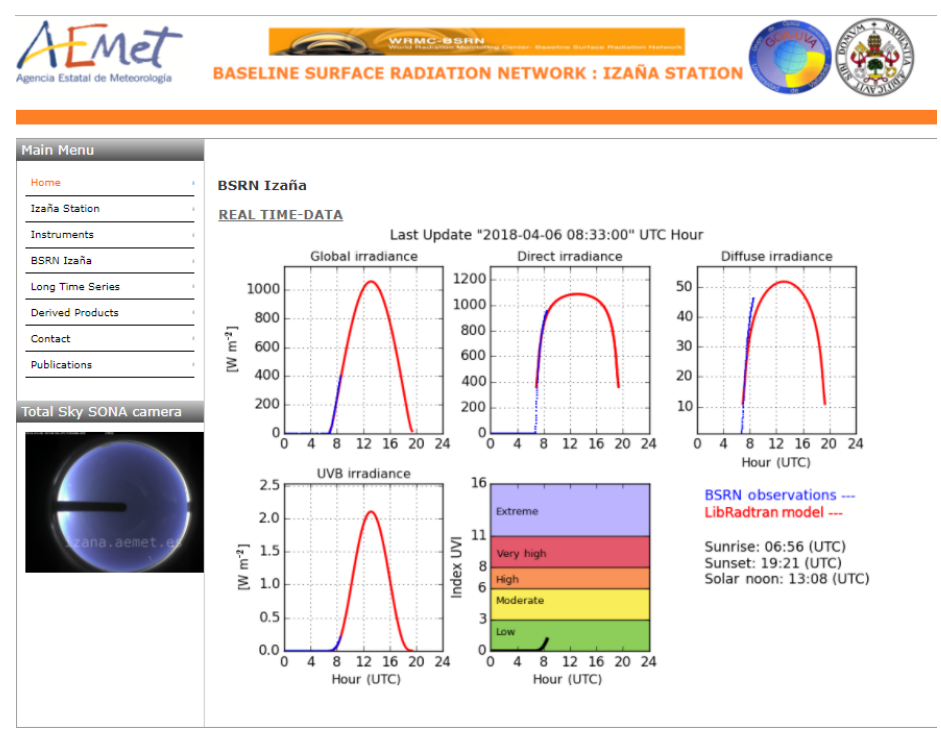
Figure 11. BSRN Izaña station home page (http://www.bsrn.aemet.es, last access: 7 February 2019).